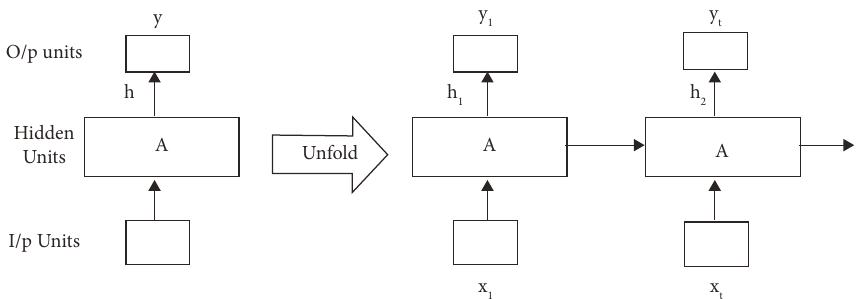
Figure 6: Illustration of RNN with unit